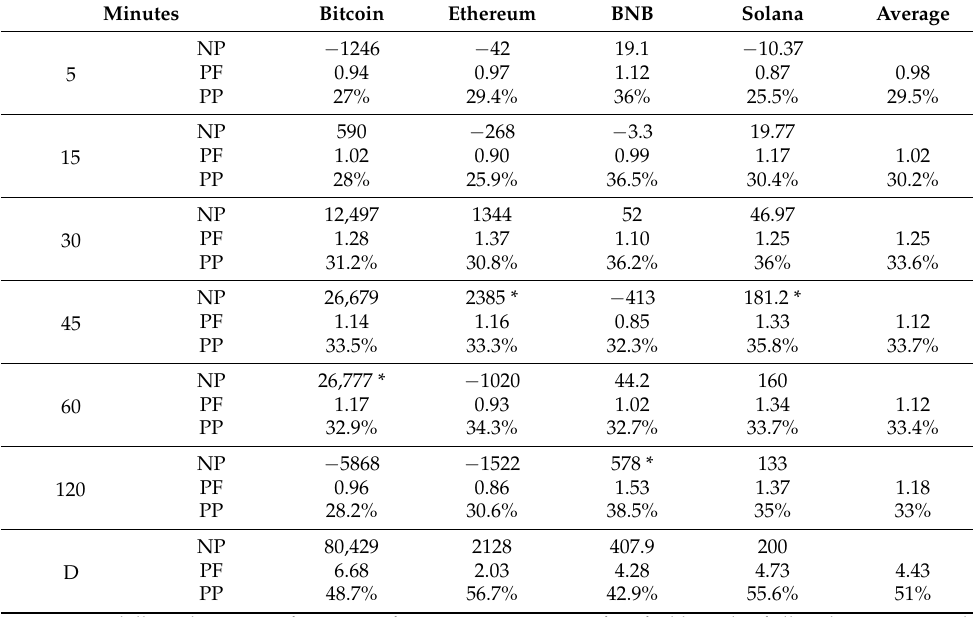
Table 1. Results of Ichimoku cloud trading